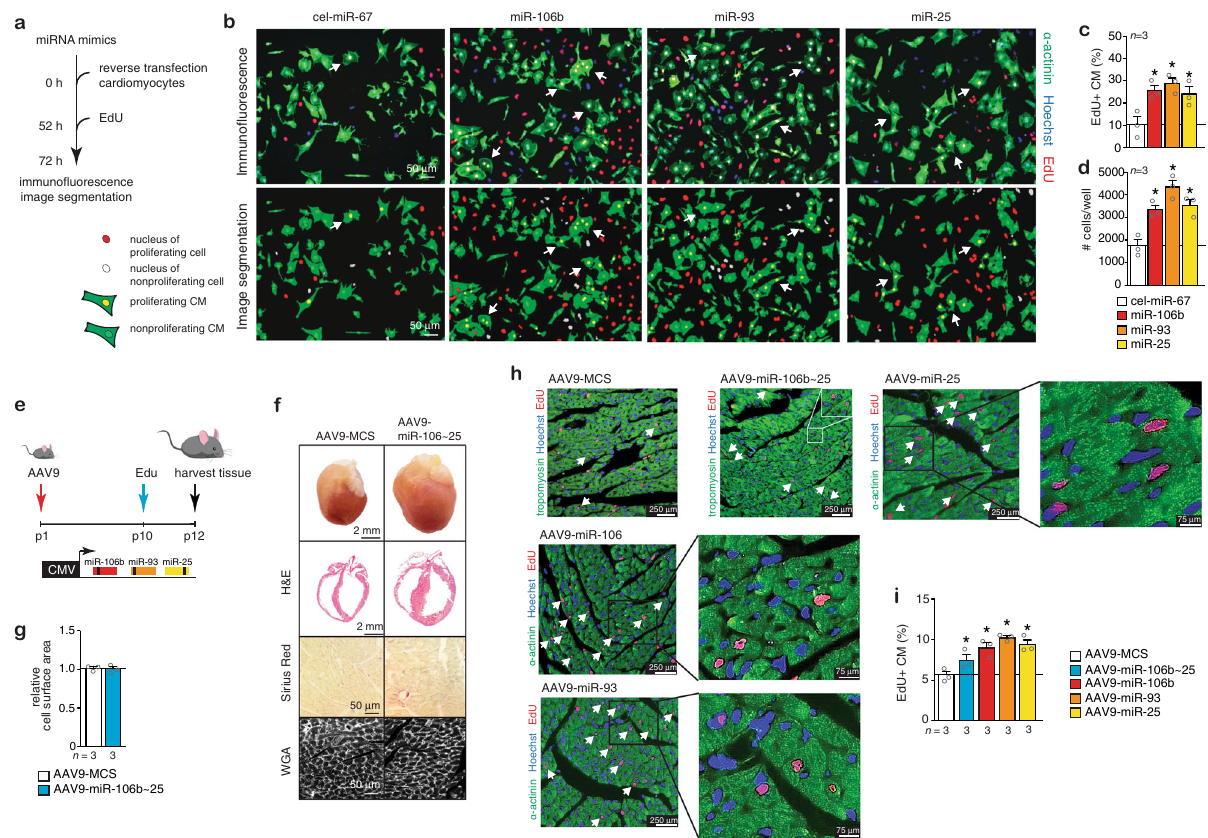
Fig. 3 Overexpression of the miR-106b~25 cluster induces cardiomyocyte (CM) proliferation. a Work fl ow of the experiment. b Representative fl uorescent microscopic images of rat CMs transfected with a control precursor miRNA, or precursors for miR-106b , miR-93 , or miR-25 and stained for α - actinin, 5-ethynyl-2 ’ -deoxyuridine (EdU), and Hoechst. Quanti fi cation of c the number of proliferating CMs ( α -actinin + , EdU + ) and d total number of CMs ( α -actinin + ) after transfection with a control miRNA, or miR-106b , miR-93 , or miR-25 , n refers to the number of transfection experiments. e Work fl ow of the study. f Representative images of whole hearts (top panels), H&E-stained sections in four-chamber view (second panel), Sirius Red stained sections (third panel) and WGA-stained (fourth panel) sections. g Quanti fi cation of the cell surface areas from WGA-stained sections. h Confocal microscopy images of heart sections of mice treated with AAV9-MCS or AAV9-miR-106b~25 and stained for α -actinin, EdU and Hoechst or α -actinin, pH3 and Hoechst. Quanti fi cation of i the number of proliferating CMs ( α -actinin + , EdU + ) and j the number of phospho-histone 3 (pH3) positive CMs ( α -actinin + , pH3 + ), n refers to number of hearts. * P < 0.05 vs corresponding control group (error bars are s.e.m.). Statistical analysis consisted of a two-tailed Student ’ s t -test ( g ) or a One-way ANOVA followed by Dunnett multiple comparison test ( c , d , i ). Source data are provided as a Source data fi